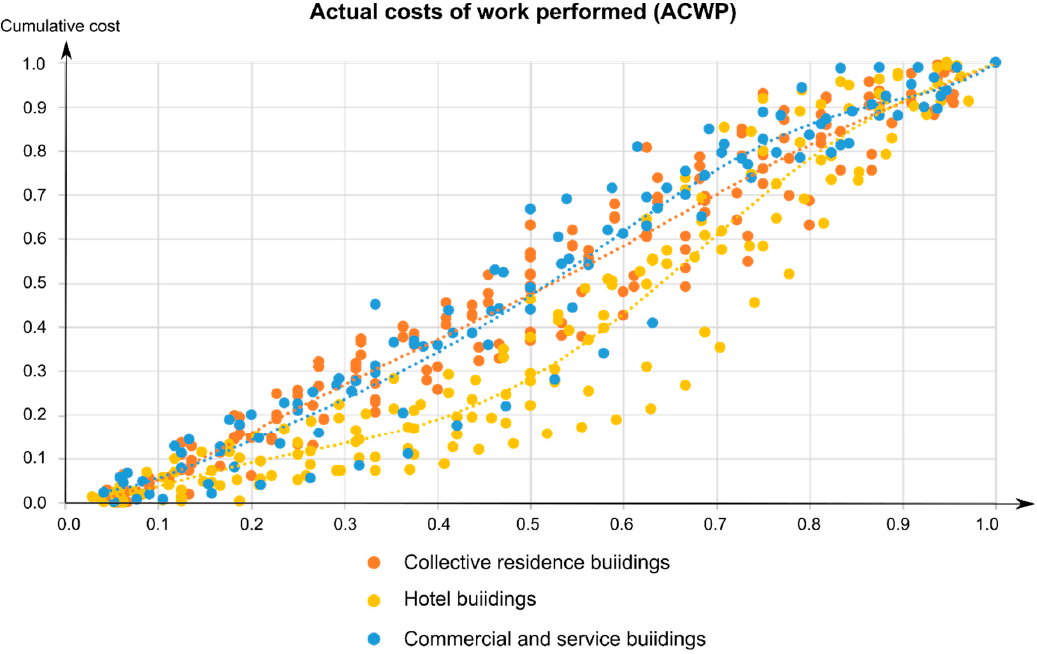
Figure 7. Best fit 3-degree curves and curve spaces for actual cost of work performed.